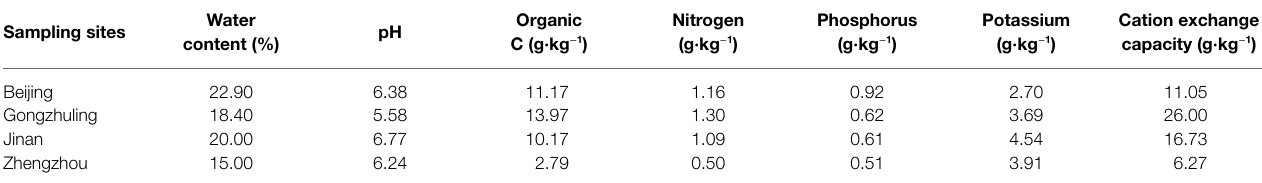
TABLE 1 | The basic physical and chemical characters of the four soil types. Water Sampling sites content